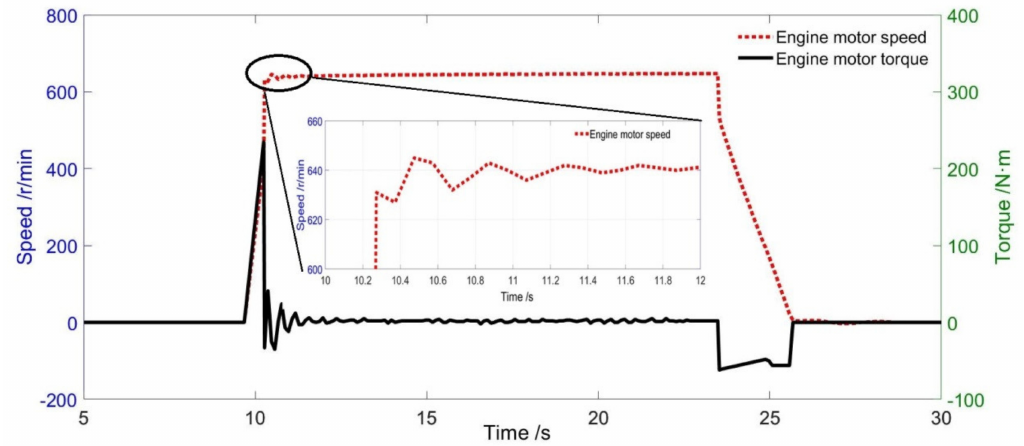
Figure 20. The process of start and stop of engine